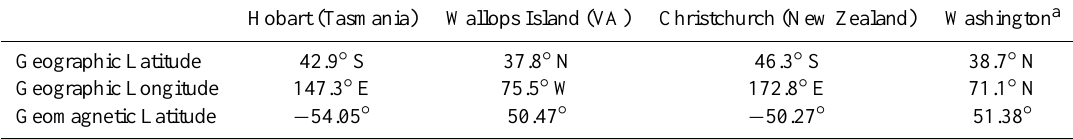
Table 1. Coordinates for the Ionosonde Stations at Wallops Island (VA), Hobart (Tasmania), Washington (D.C.) and Christchurch (NZ). To account for secular changes in the geomagnetic field, the magnetic latitudes are the averages of years 1964 and 1976, calculated using the Definite/International Geomagnetic Reference Field (DGRF/IGRF) model. See website http://omniweb.gsfc.nasa.gov/vitmo/cgm.html.